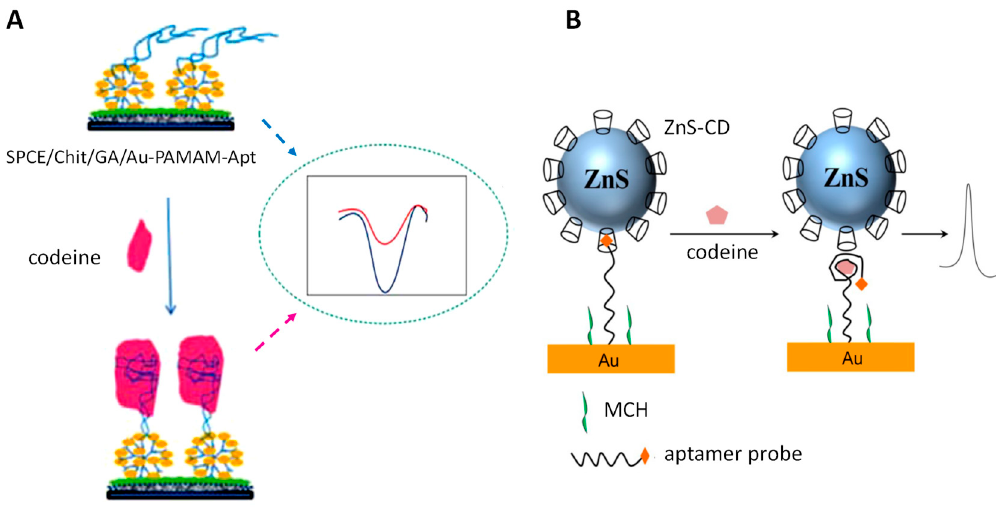
Figure 4. Schematic display of the fundamentals involved in the preparation of aptasensors for the determination of codeine. Reprinted from [55] ( A ) and [56] ( B ), with permission.